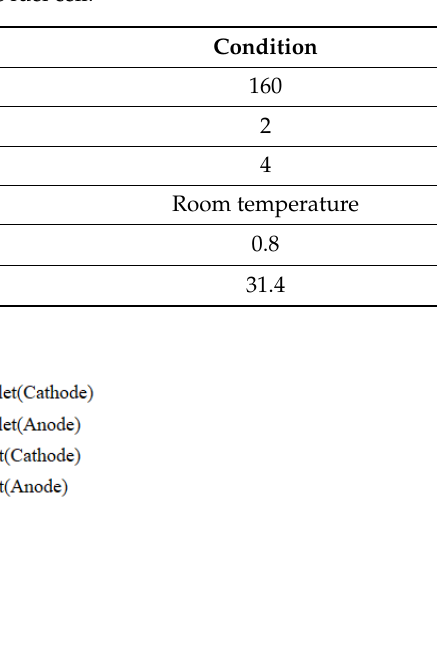
Table 1. Test conditions of the high-temperature fuel cell.